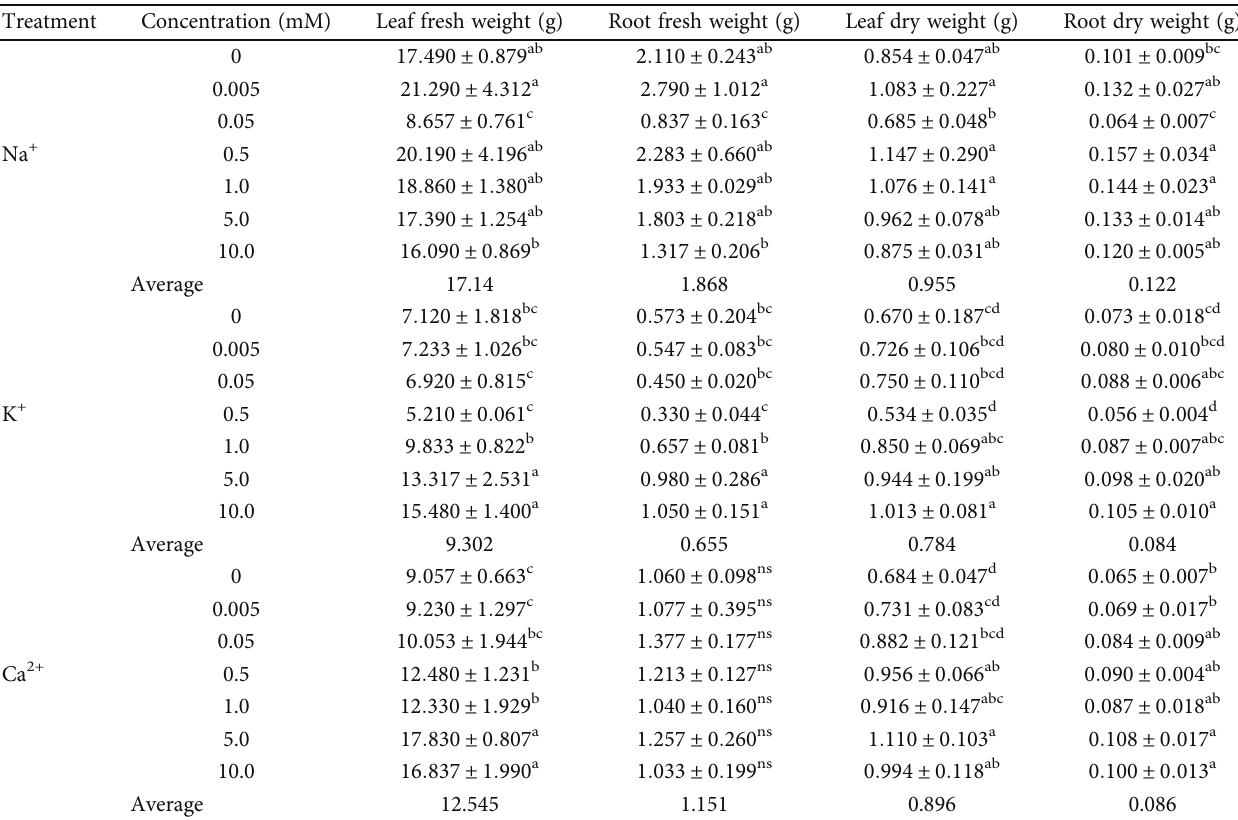
Table 3: E ff ects of exposure to the di ff erent concentrations of Na + , K + , and Ca 2+ on biomass while the lettuces were cultivated in cesium concentration of